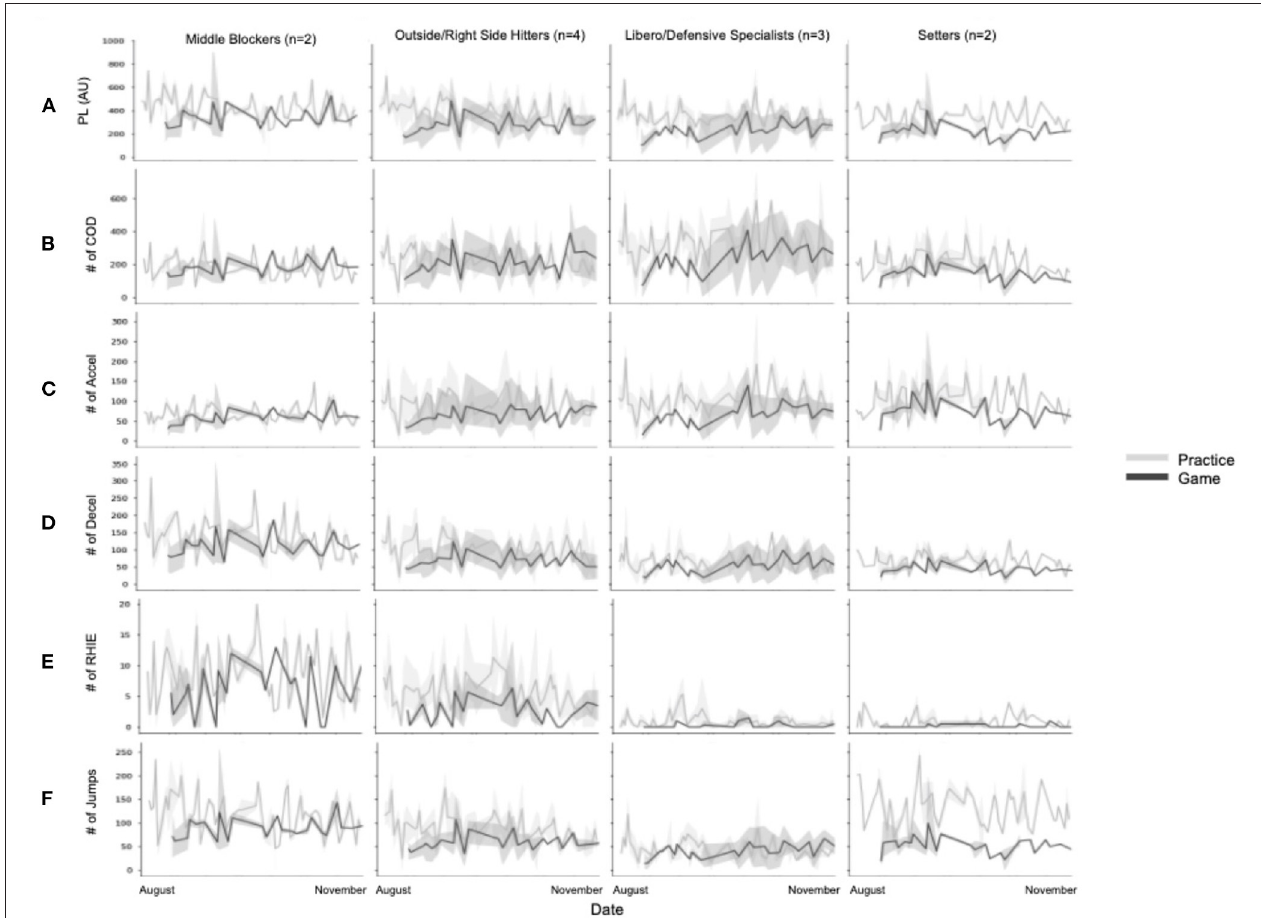
FIGURE 4 | Mean accelerometry values over the season by position and session type. (A) Average playerload (PL); (B) Average number of change of directions (COD); (C) Average number of accelerations (accel); (D) Average number of decelerations (decel); (E) Average number of jumps; (F) Average number of repeated high-intensity efforts (RHIE). The shaded area represents 95%